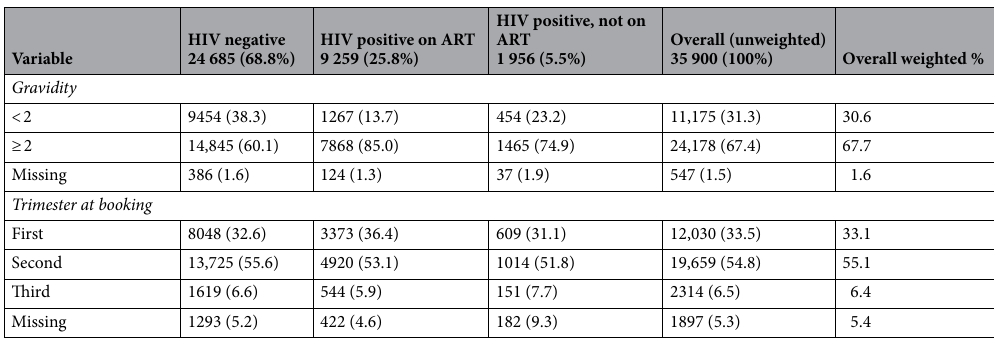
Table 1. Characteristics of eligible*pregnant women enrolled in the 2019 ANC HIV survey overall and by HIV/ART status, N = 35,900. *Eligible for analysis of syphilis screening coverage.